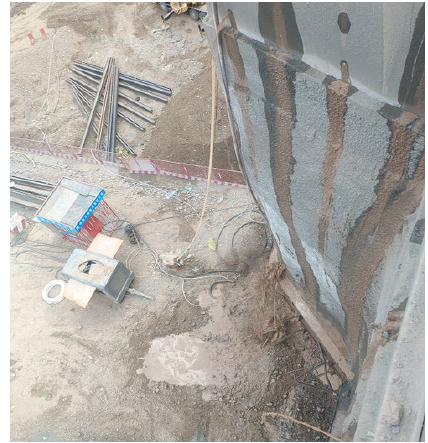
Figure 18. Pit site conditions.